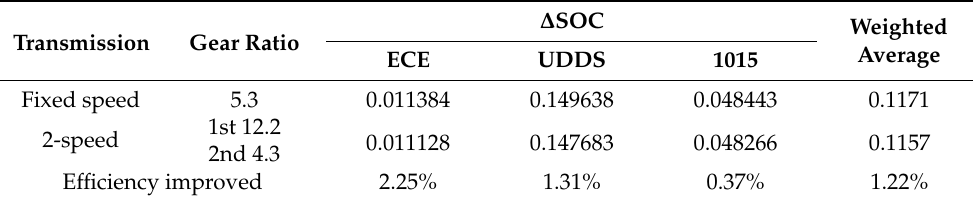
Table 4. Energy consumption comparison.